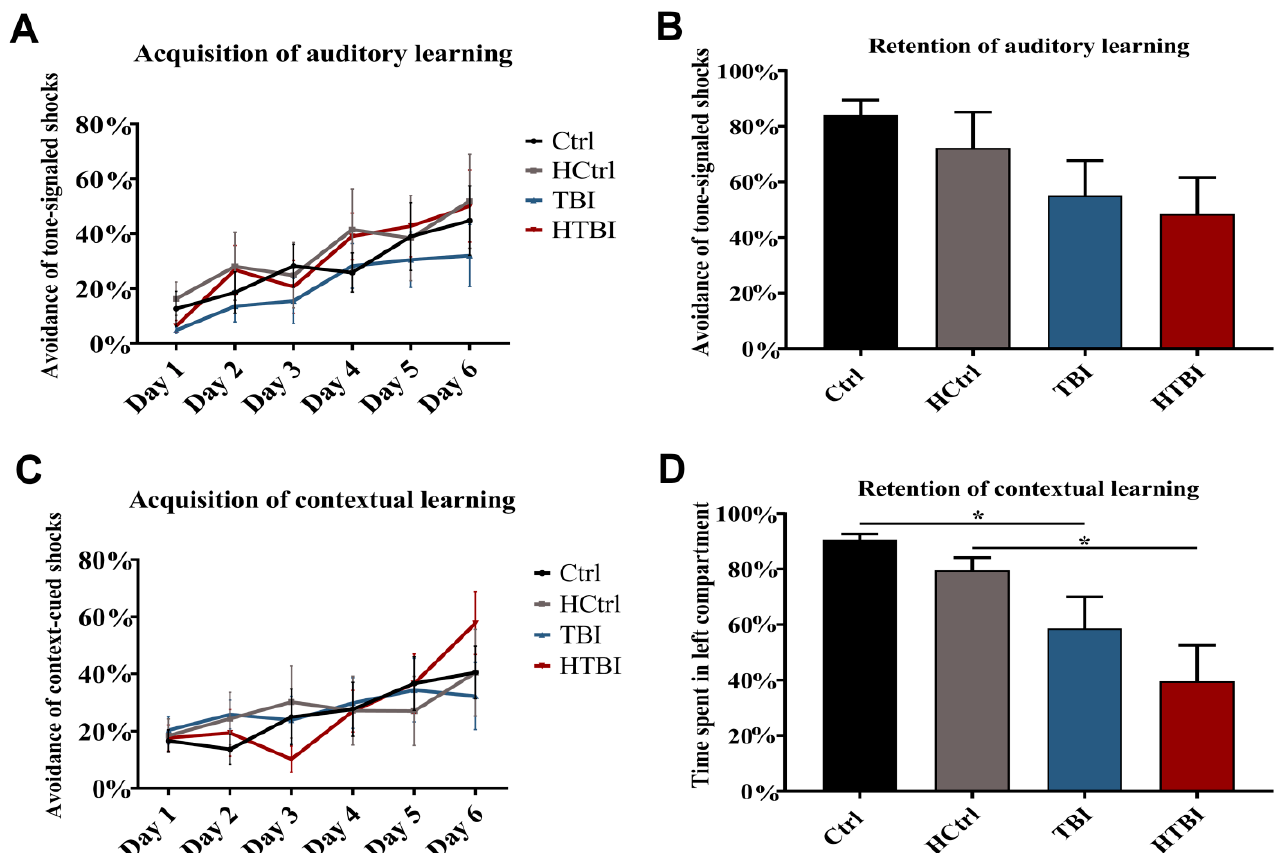
Figure 5. Learning deficits in the modified active avoidance (MAAV) test. Repeated measures two-way ANOVA with post hoc Fisher’s least significant difference (LSD) revealed that all groups were comparable in learning to avoid the tone-signaled electrical foot-shocks in the left chamber ( p > 0.05) ( A ). There was a trend for both TBI and HTBI groups to have lower retention of auditory learning, compared to their respective controls, but there was not a statistically significant difference ( B ). In the acquisition of contextual learning subtest, all groups were comparable in learning to avoid the context-cued electrical foot shocks ( C ) in the right chamber ( p > 0.05, two-way ANOVA with repeated measures with post hoc Fisher’s LSD). However, both TBI and HTBI groups had deficits in the retention of contextual learning ( D ), as revealed by statistically significant lower times spent on the left side, compared to their respective controls (90.62 ± 2.00% for Ctrl, 79.47 ± 4.66% for HCtrl, 58.65 ± 11.33% for TBI, 39.59 ± 12.94% for HTBI, p < 0.05, one-way repeated measures ANOVA with post hoc Fisher’s LSD). There were no statistically significant differences in all other paired comparisons. Asterisks indicate statistically significant differences ( p < 0.05). Mean ± SEM are represented. (Ctrl: control, n = 12; HCtrl: heparinized control, n = 16;